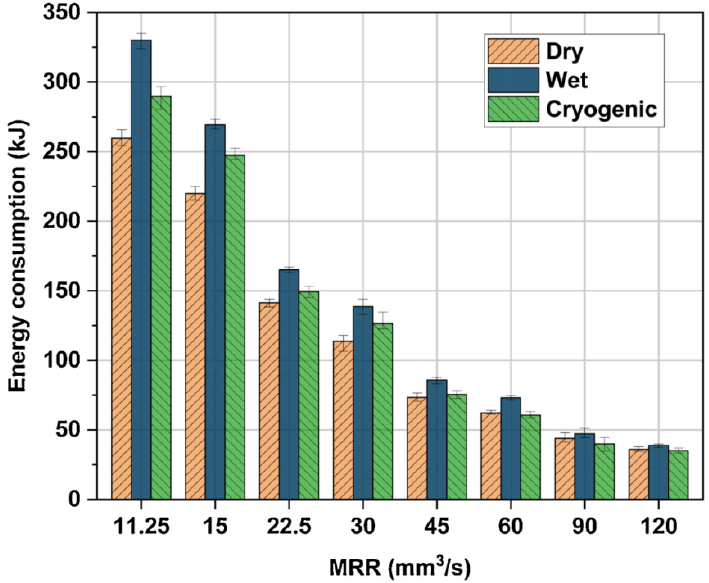
Figure 13. Effect of variation in MRR on energy consumption in turning of Inconel-718 [96].